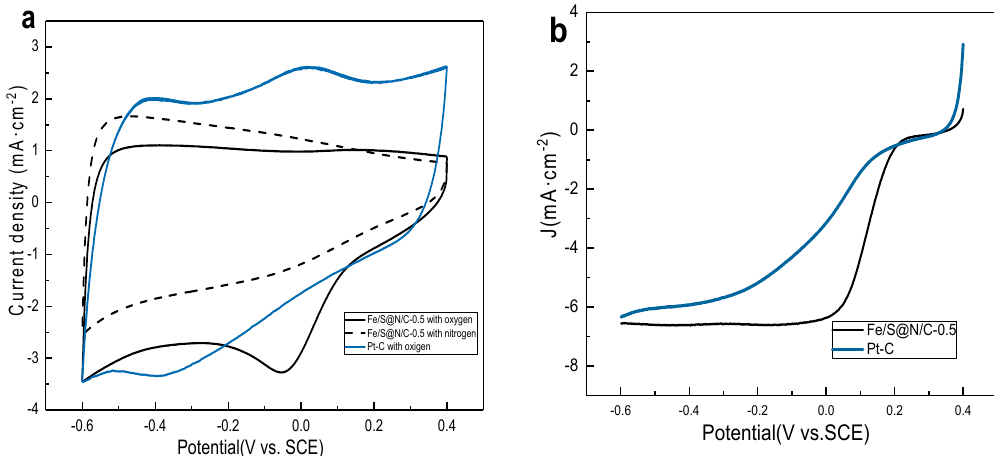
Figure 4. ( a ) CV curves of Fe / S@N / C-0.5 and 20% Pt-C in O 2 and N 2 -saturated 0.01 M PBS solution. ( b ) Linear sweep voltammogram (LSV) curves of Fe / S@N / C-0.5 and 20% Pt-C in O 2 -saturated 0.01 M PBS solution at 1600 rpm.